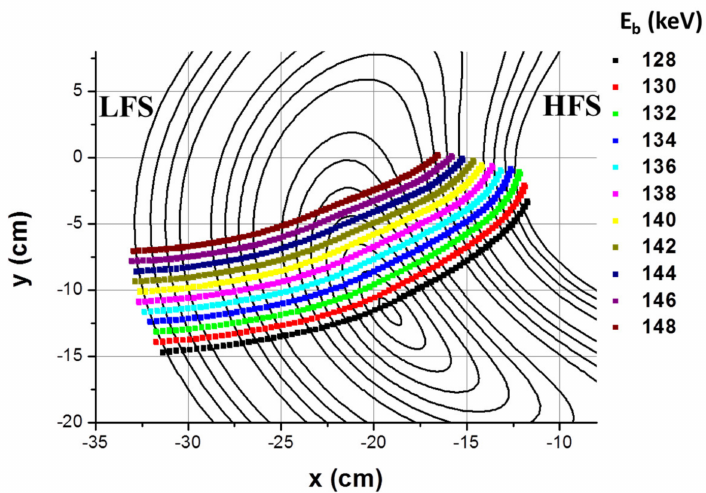
Figure 2. HIBP detector grid for the vertical cross section of TJ-II for Cs + probing ions. The detector grid consists of 11 detector lines (in different colors) of equal energy E b . Each detector line scans the plasma cross section from high-field side to low-field side. (Reprinted from [4], with the permission of AIP